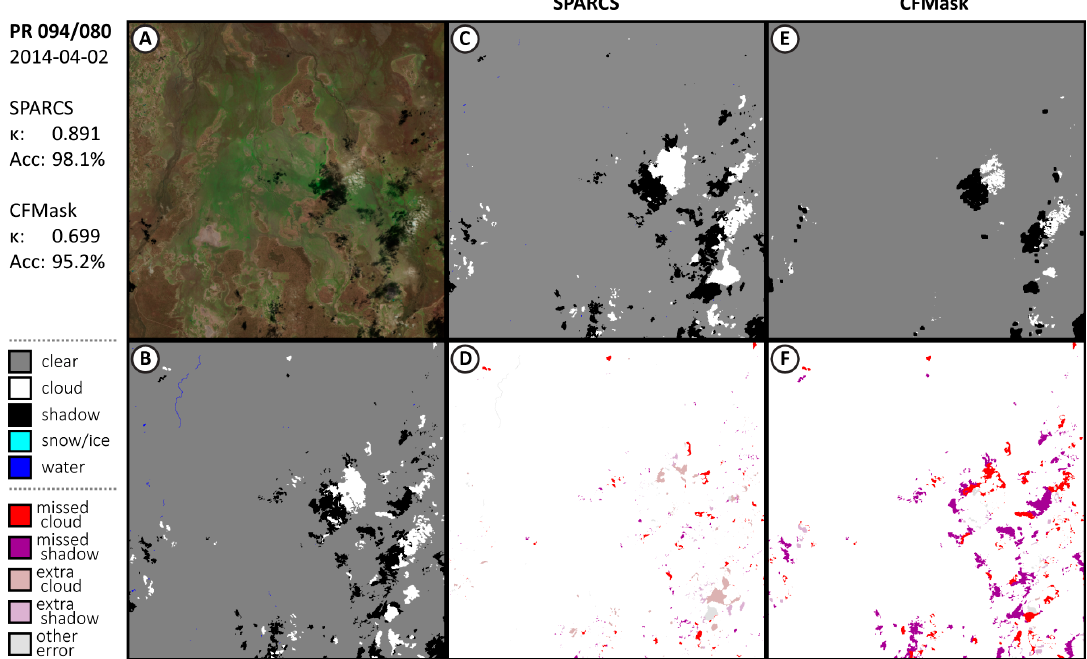
Figure A3. Results for validation test image PR 094/080, withfalse color image used during interpretation (A), the manually labeled interpretation (B), generated masks from SPARCS (C) and CFMask (E), and respective spatial distribution of errors (D, F).